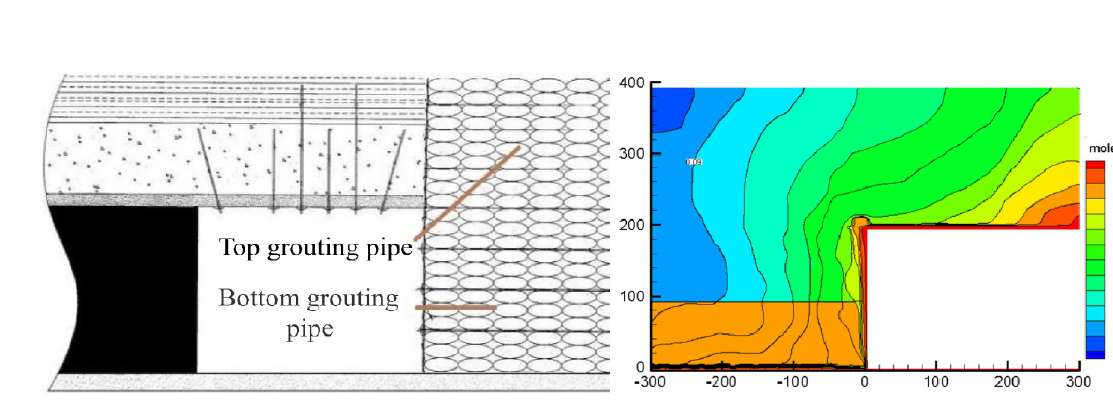
PLOS ONE | https://doi.org/10.1371/journal.pone.0267631 May 27,